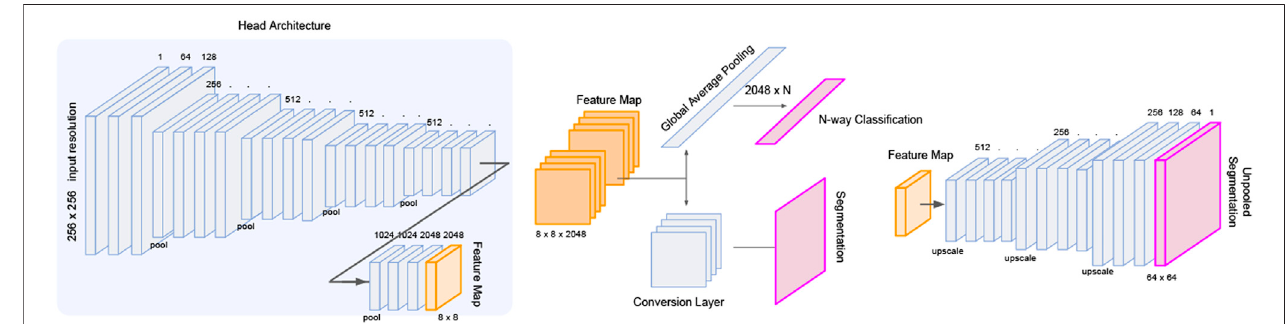
FIGURE 3 | LatentCADx Architecture. LatentCADx consist of a modular architecture which allows weight transfer and selective training of layers and prediction outputs. We outline a procedural approach to training LatentCADx such that features driving high classi fi cation accuracy are consistent with fi nal segmentation image (diagram created via Google Slides